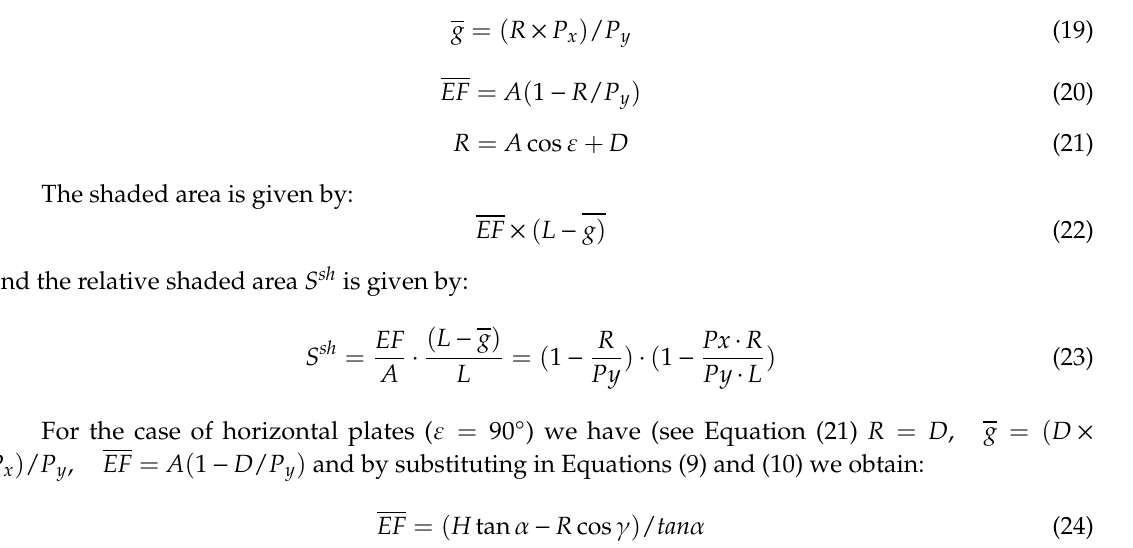
Figure 10. Inclined plates one above another.